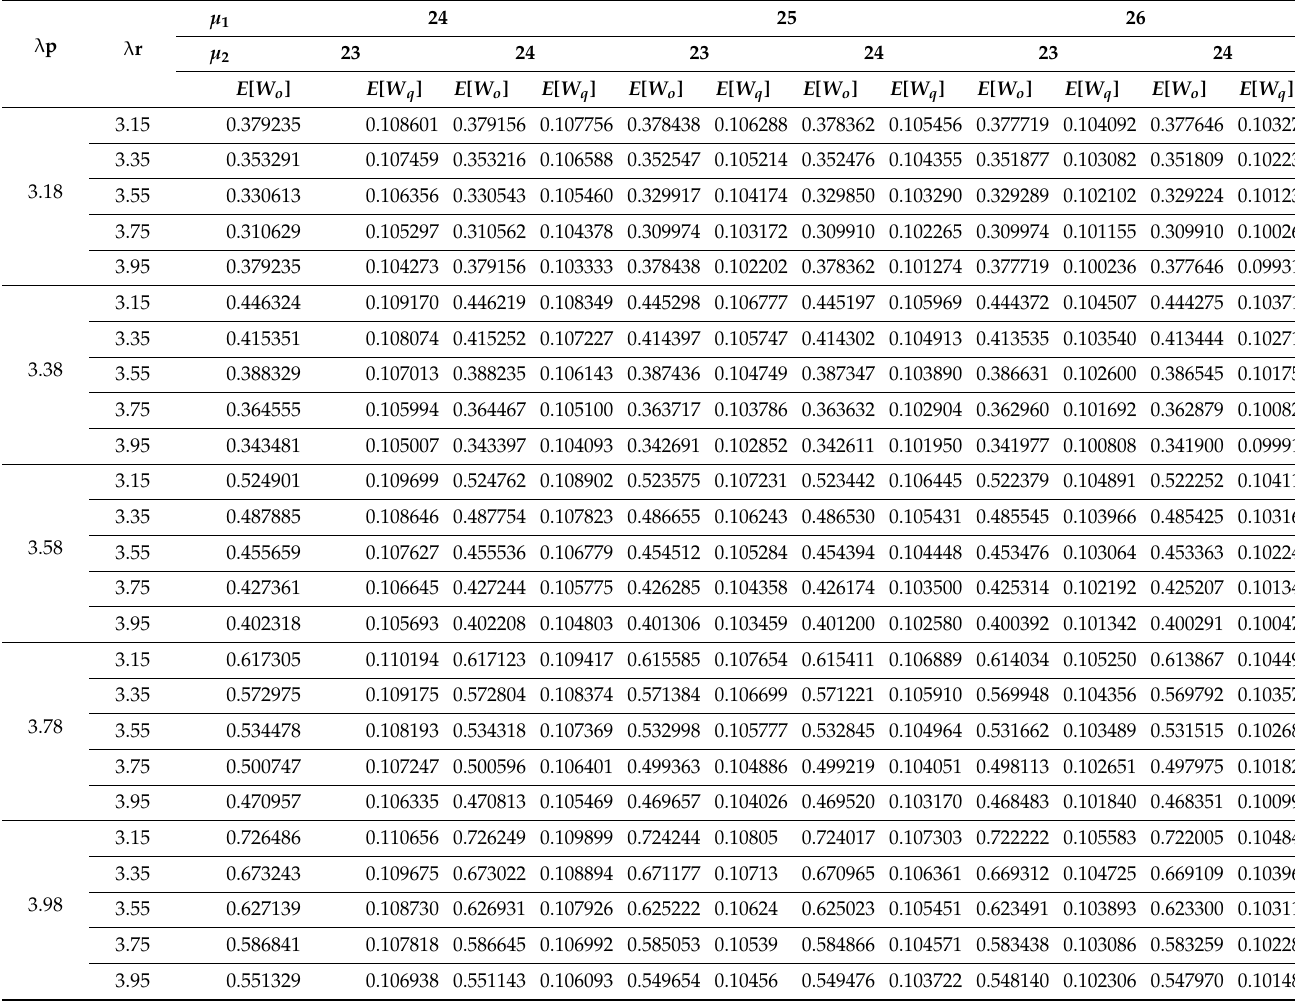
Table 7. Impact of λ p , λ r , µ 1 , and µ 2 on the E [ W o ] and E [ W q ] .